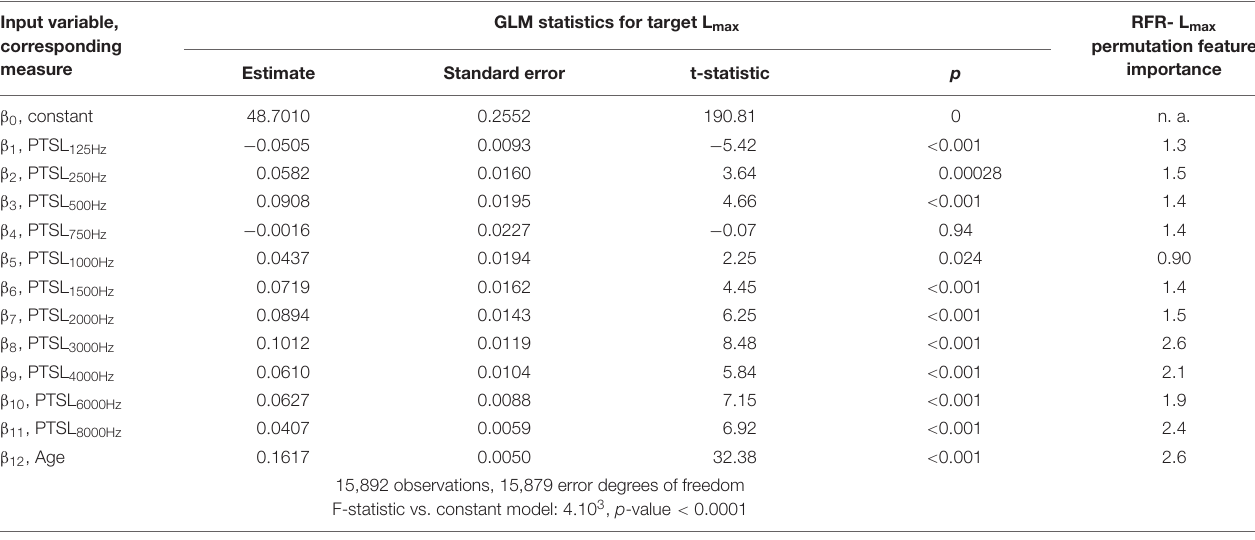
TABLE 3 | GLM parameters for target variable L max .